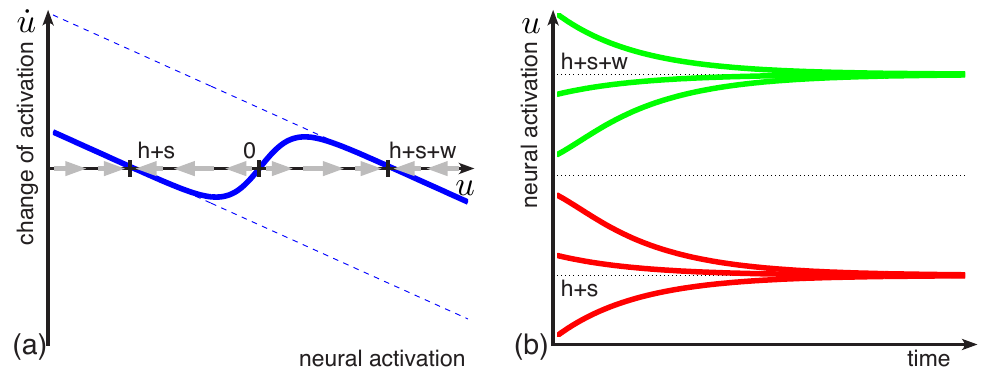
Figure 8: Dynamics of a single neural activation variable with self-excitation (Equation 12) under a medium stimulus. Panel (a) shows the phase plot (solid) and as a reference the phase plots for the system without self-excitation, with and without stimulus (dashed). The grey arrows sketching the vector field show how the direction of the rate of change switches between negative and positive at the repellor 0 . Panel (b) illustrates how several example trajectories starting above (green) and below zero (red) relax to different attractors.